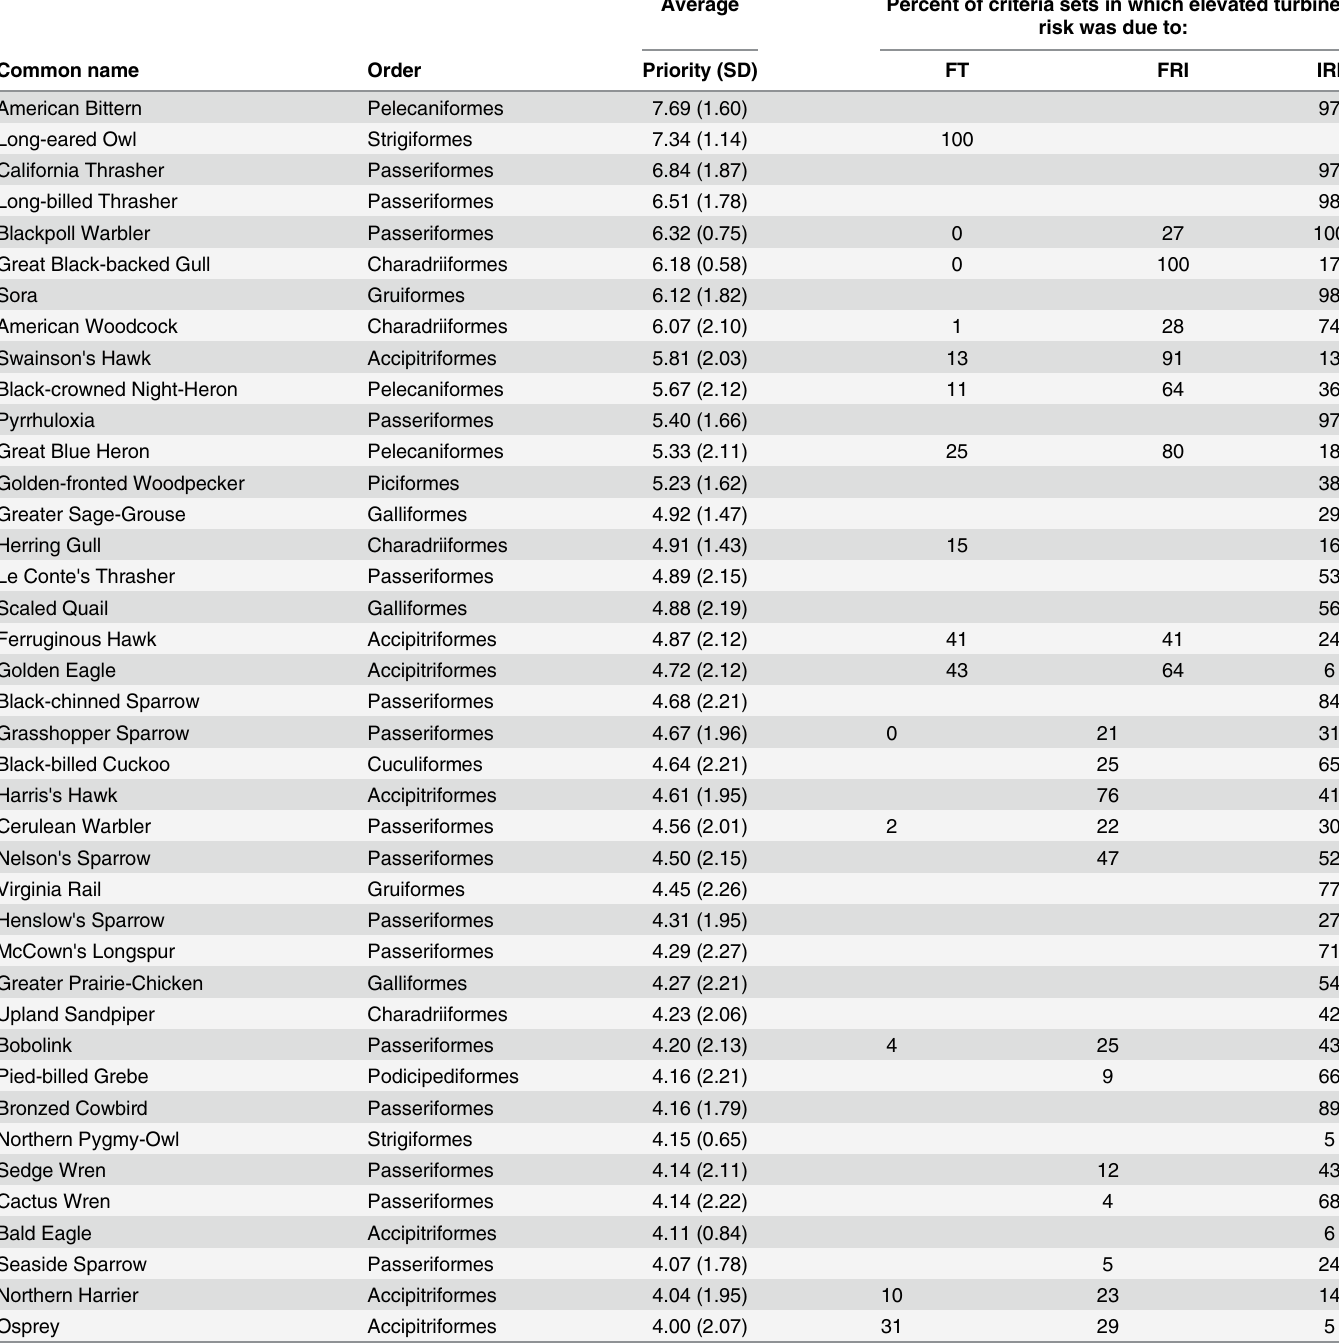
Table 3. High priority avian species.